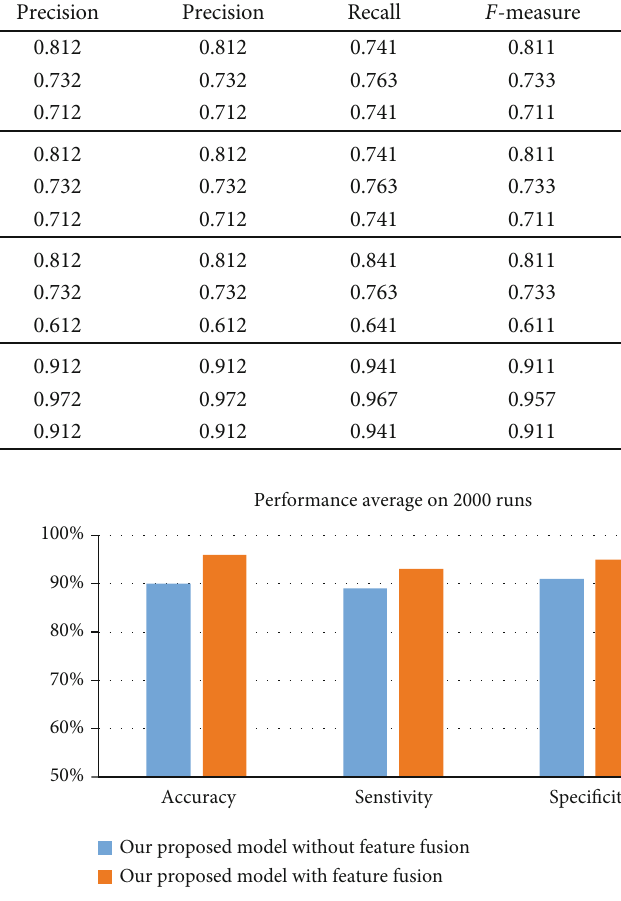
Figure 11: Accuracy results for proper feature fusion.